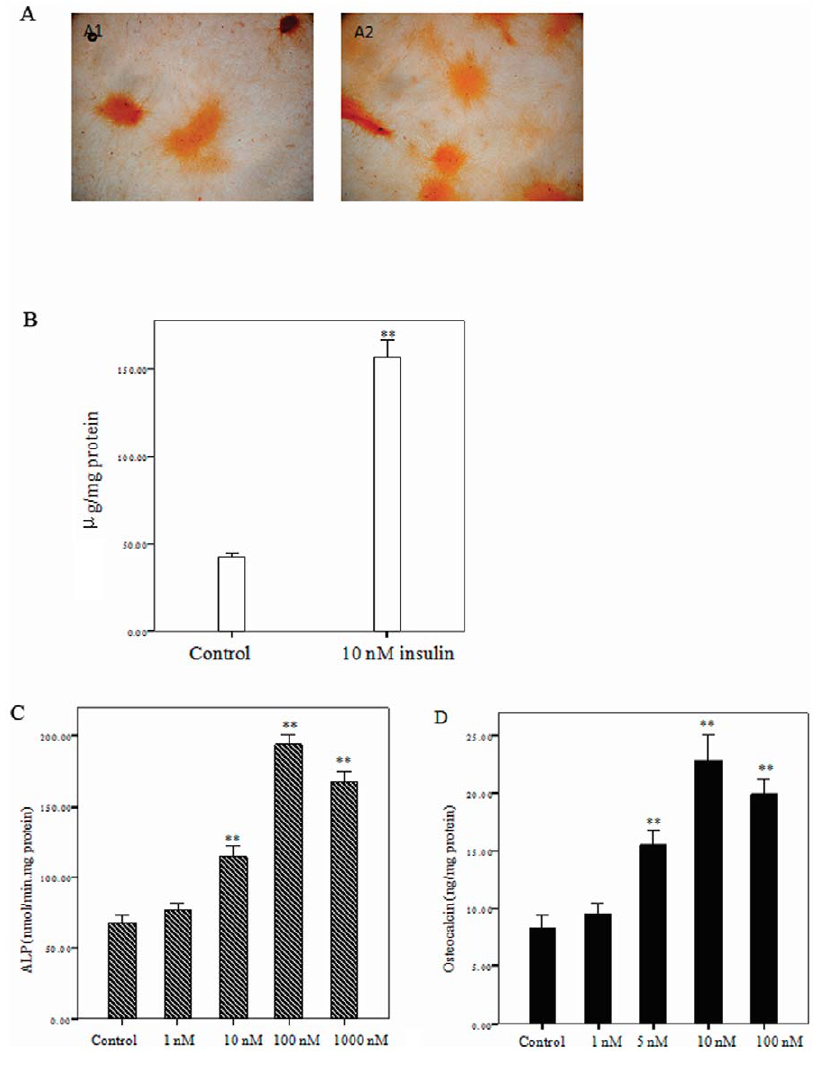
Figure 3. Insulin promoted the mineralization of the matrix in calcifying vascular smooth muscle cells (CVSMCs). CVSMCs were cultured in DMEM that contained 10% fetal bovine serum (FBS) in 24-well plates, in the presence of vehicle or 10 nM insulin for 20 days. Mineralization of the matrix was determined by Alizarin red S staining. (A) Representative microscopic view at a magnification of 6 100. Left panel showed CVSMCs incubated with vehicle, and the right panel showed CVSMCs incubated with 10 nM insulin for 12 days. (B) Quantification of Alizarin red S stain through extraction with cetyl-pyridinium chloride. The amount of released dye was quantified by spectrophotometry at 540 nm. The bars represent mean 6 standard deviation (SD) ( n =4; ** p , 0.01 vs. control). (C) Cells were treated with vehicle (serum-free medium) or insulin at 1, 5, 10, or 100 nM for 48 h in serum-free DMEM. ALP activity were determined and normalized to cell total protein. The dose–response of insulin on ALP activity in cultured CVSMCs. (D) Cells were treated with vehicle (serum-free medium) or insulin at 1, 5, 10, or 100 nM for 48 h in serum-free DMEM. Osteocalcin secretion were determined and normalized to cell total protein. The dose–response of insulin on osteocalcin secretion in cultured CVSMCs. The bars represent mean 6 standard deviation (SD) (** p , 0.01 vs. control, * p , 0.05 vs. control, n